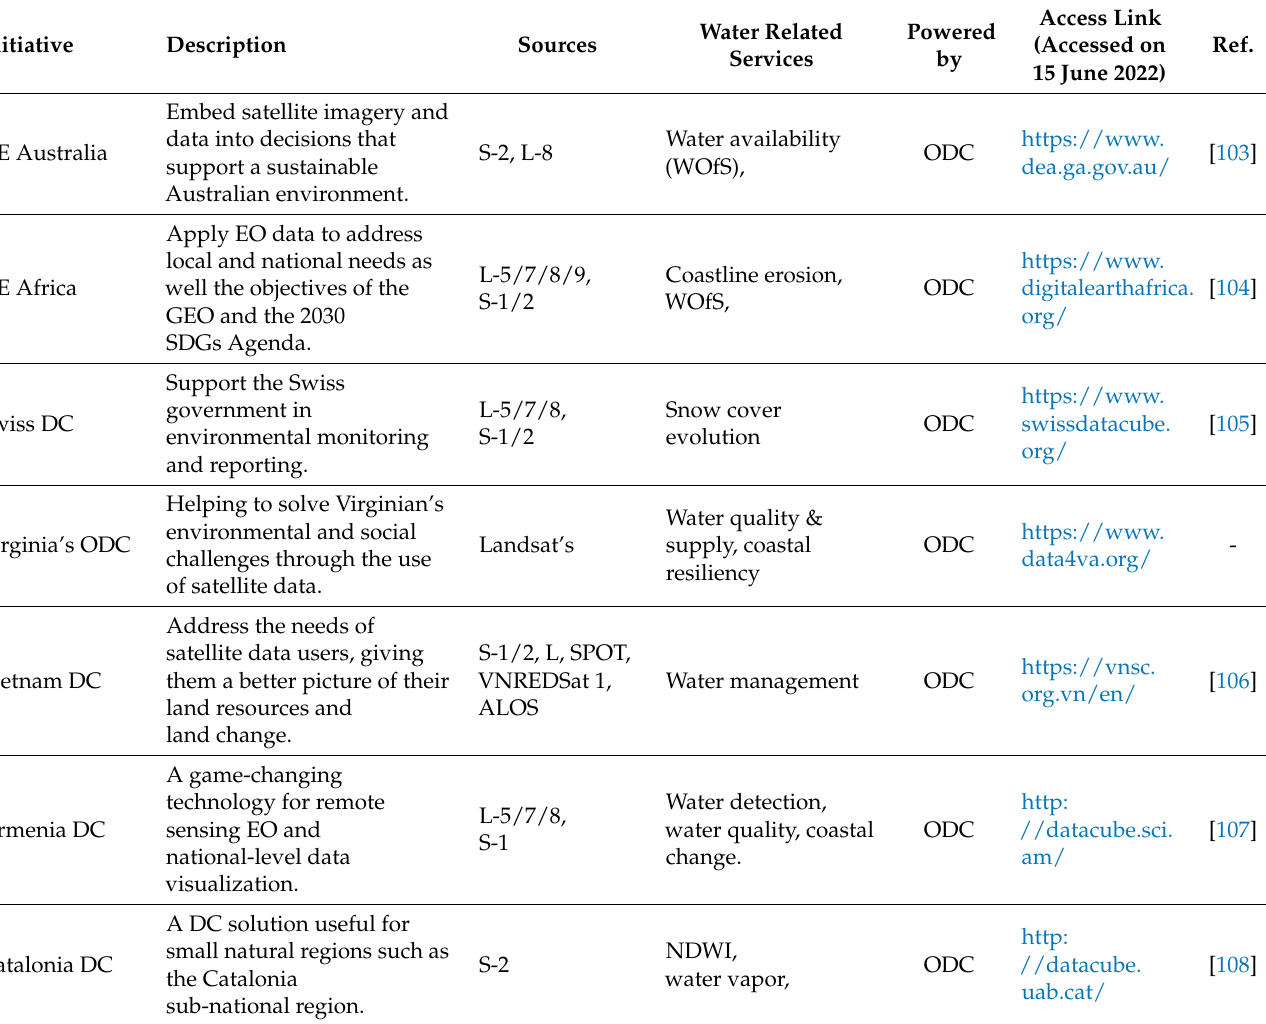
Table 4. Examples of DC technology adopted at various scales in support of EO-driven water re- sources management (in sources column, S = Sentinel and L =